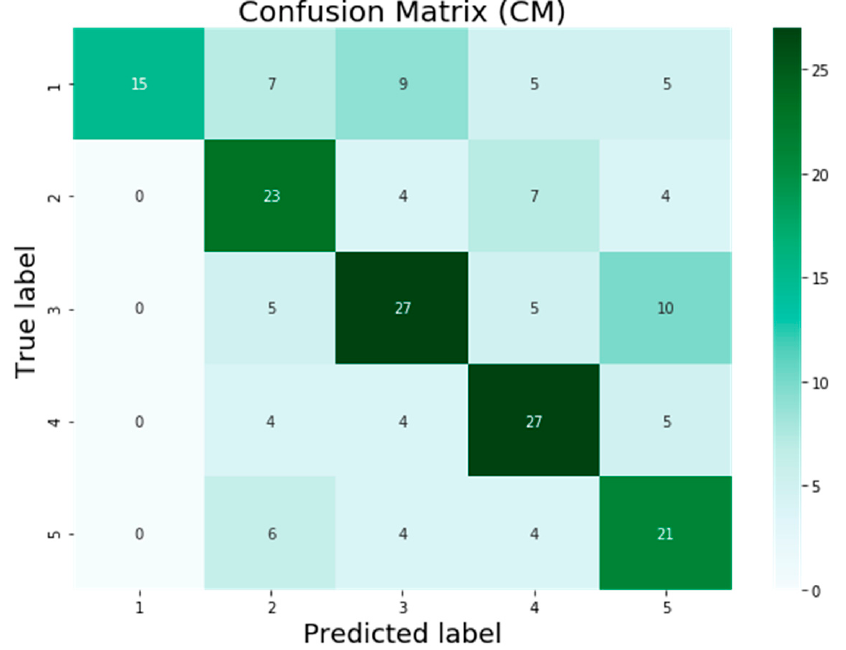
Figure 7. Confusion matrix (SVM).